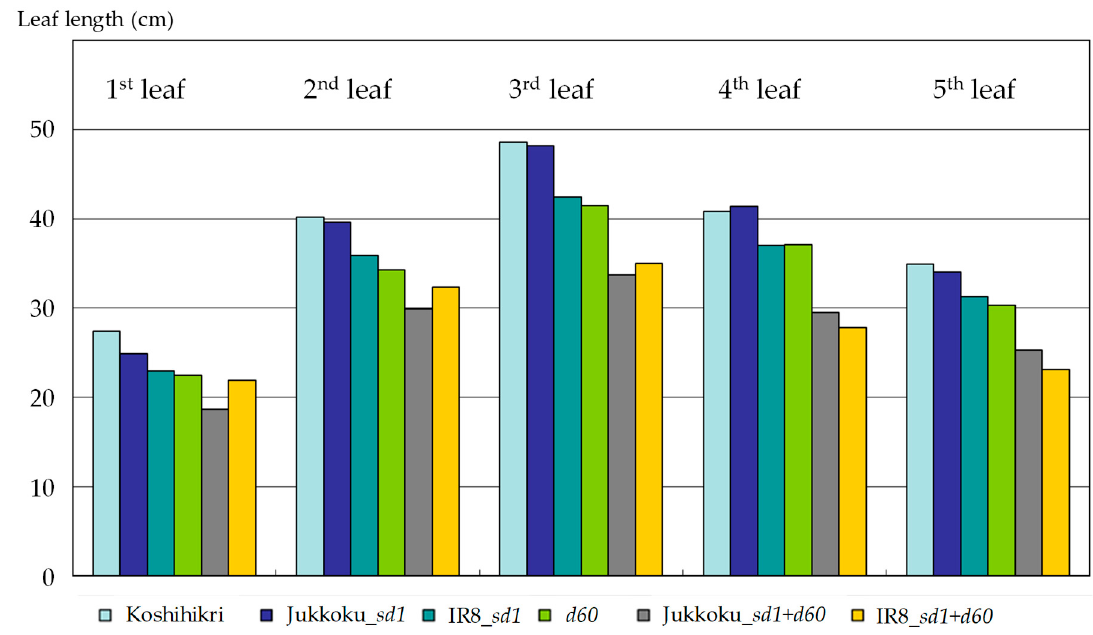
Figure 2. Effect of semidwarf and double dwarf genes to leaf length. Upper five leaves, arising from the main culm, were measured. Except for Jukkoku _sd1 line. leaves of the semidwarf and double dwarf lines were slightly shorter than that of Koshihikari.